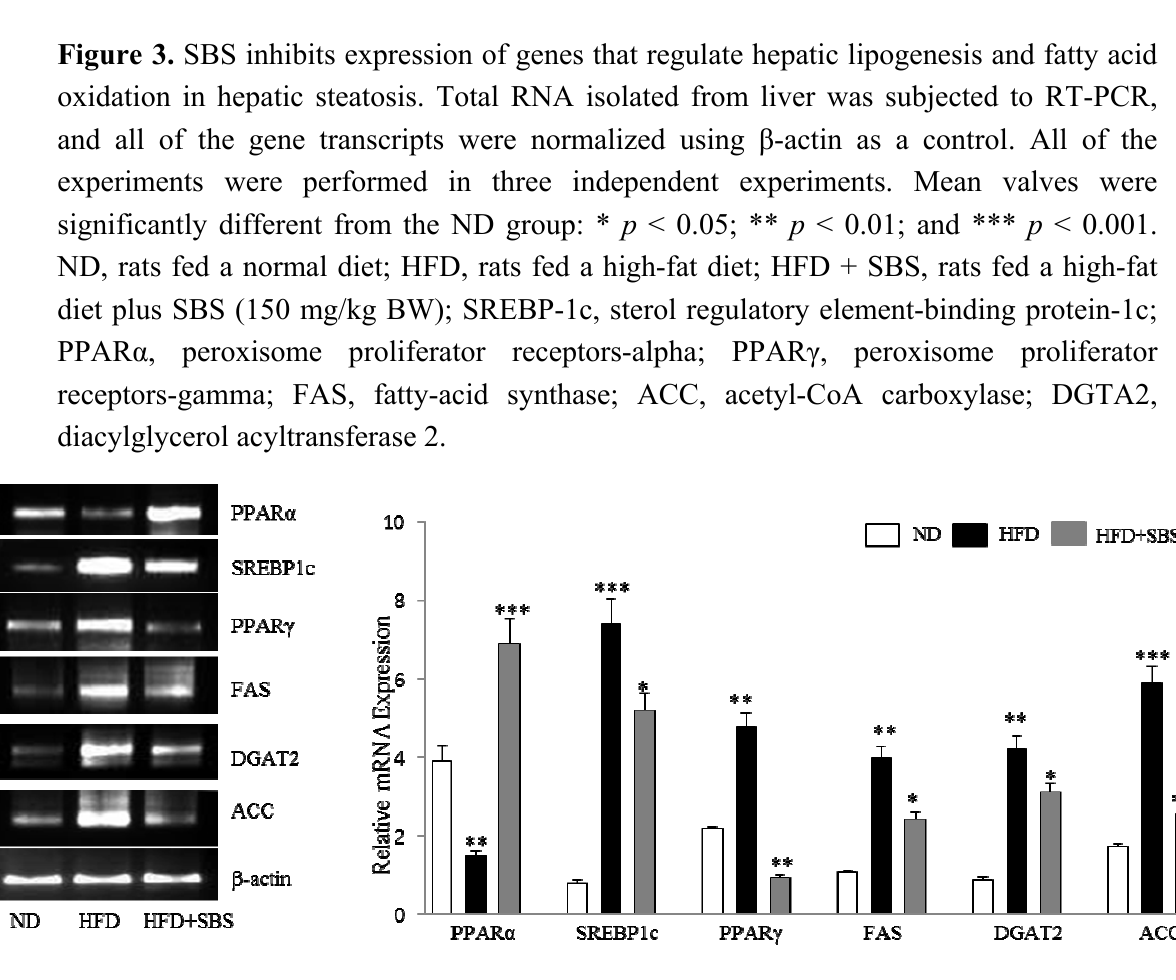
Figure 3. SBS inhibits expression of genes that regulate hepatic lipogenesis and fatty acid oxidation in hepatic steatosis. Total RNA isolated from liver was subjected to RT-PCR, and all of the gene transcripts were normalized using β -actin as a control. All of the experiments were performed in three independent experiments. Mean valves were significantly different from the ND group: * p < 0.05; ** p < 0.01; and *** p <